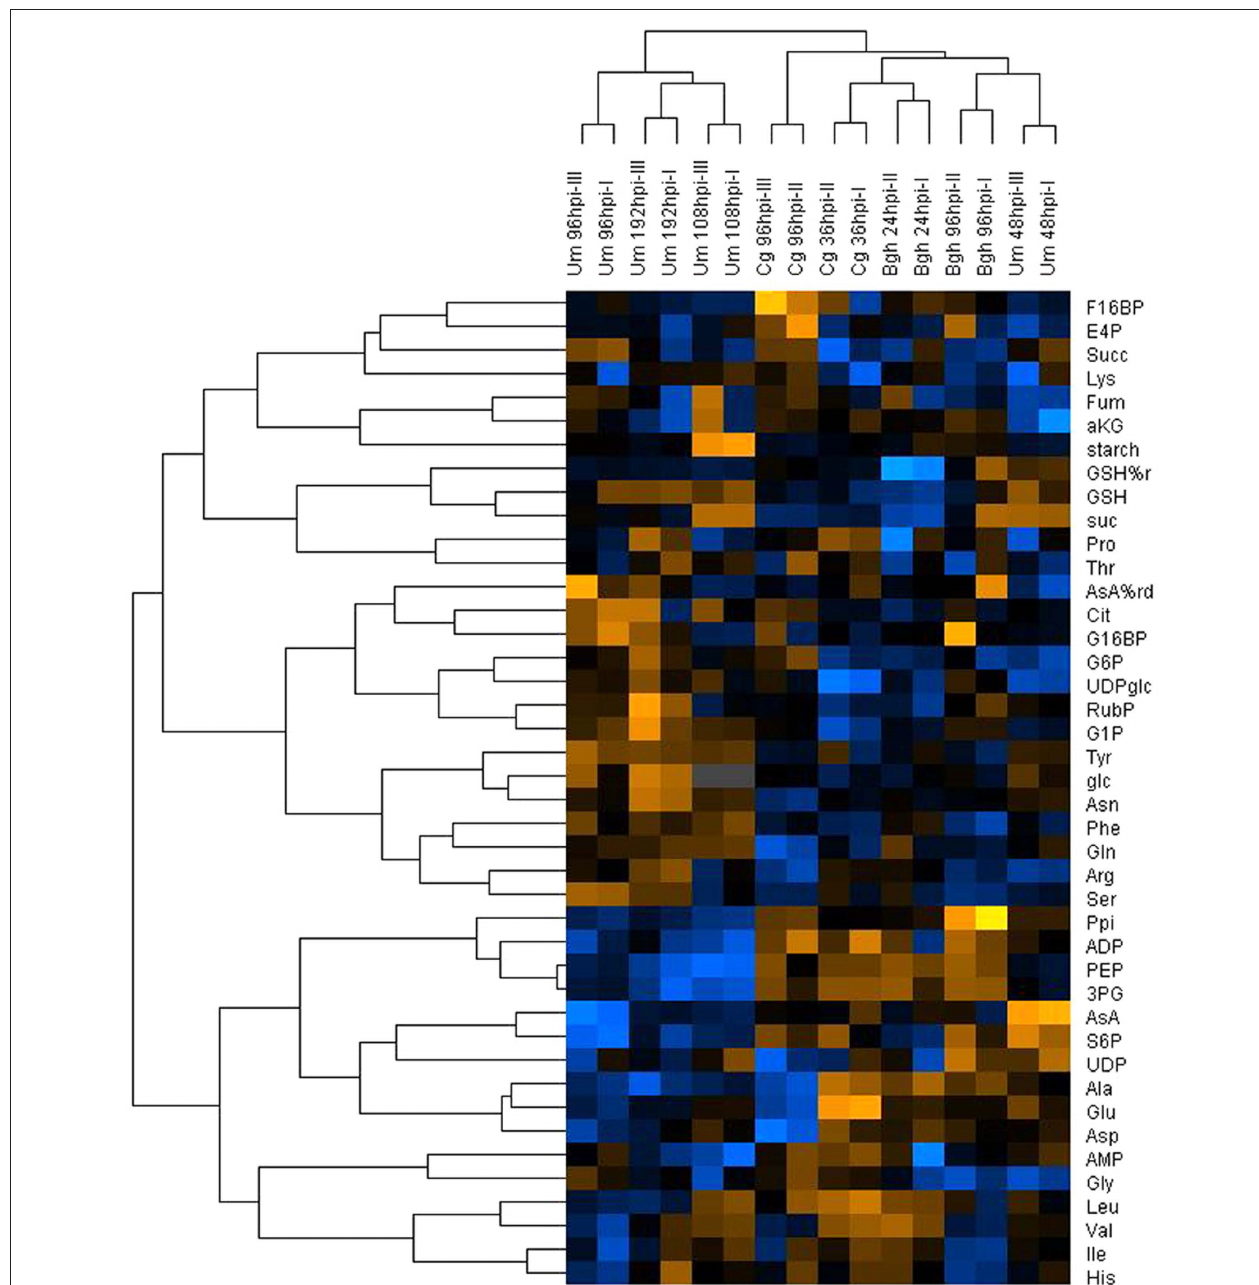
Figure 2 | Hierarchical cluster analysis of metabolome data from infected leaves. Mean values of metabolite contents from four biological replicates of infected and mock control leaves harvested at the indicated time points after infection with the respective pathogens ( Bgh , Blumeria graminis f.sp. hordei ; Cg , Colletotrichum graminicola ; Um , Ustilago maydis ) were used to calculate the metabolite ratio infected/mock for the indicated experimental replicates. After log transformation of the data, median centered ratios were normalized and hierarchical clustering analysis (HCA) was performed using the complete linkage algorithm of the program Cluster v2.11 (Eisen et al., 1998 – www.eisenlab.org) and the results were visualized using Maple Tree (http://mapletree.sourceforge. net/). Metabolite ratios from two independent experiments (indicated by Roman numbers) of every pathosystem were used for HCA. Color intensity correlates